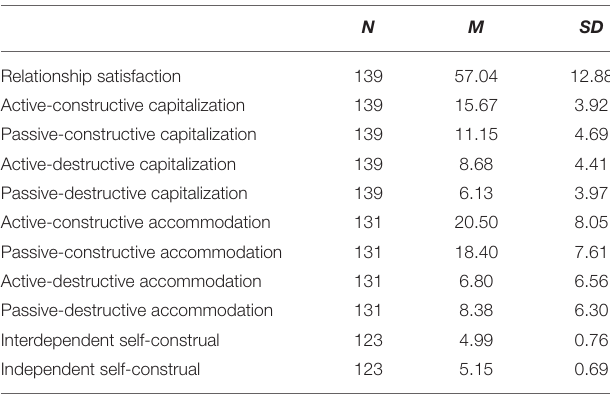
TABLE 2 | Descriptive statistics of all main